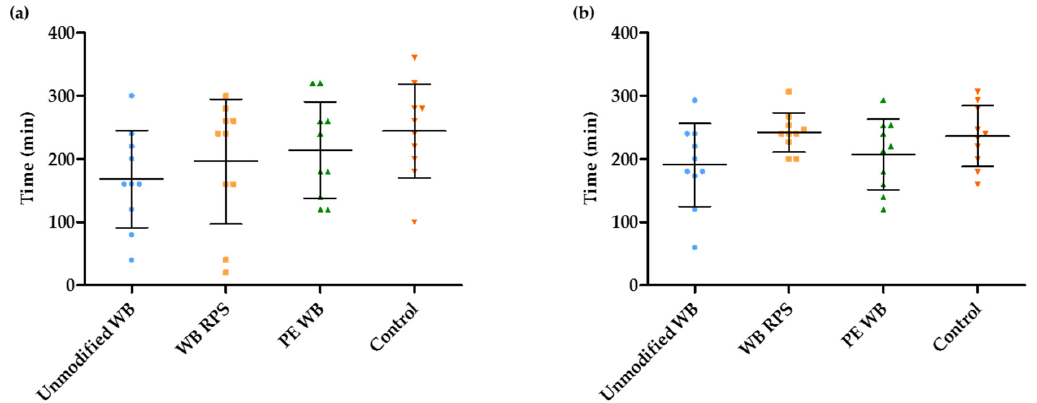
Figure 5. Wheat bran (WB) supplementation did not affect the start of the fermentation based on the 13 CO 2 ‐ breath excretion ( a ) nor 13 C ‐ labeled short ‐ chain fatty acids (SCFA) concentrations in plasma ( b ) ( n = 10). The middle line represents the mean with the standard deviation (whiskers).